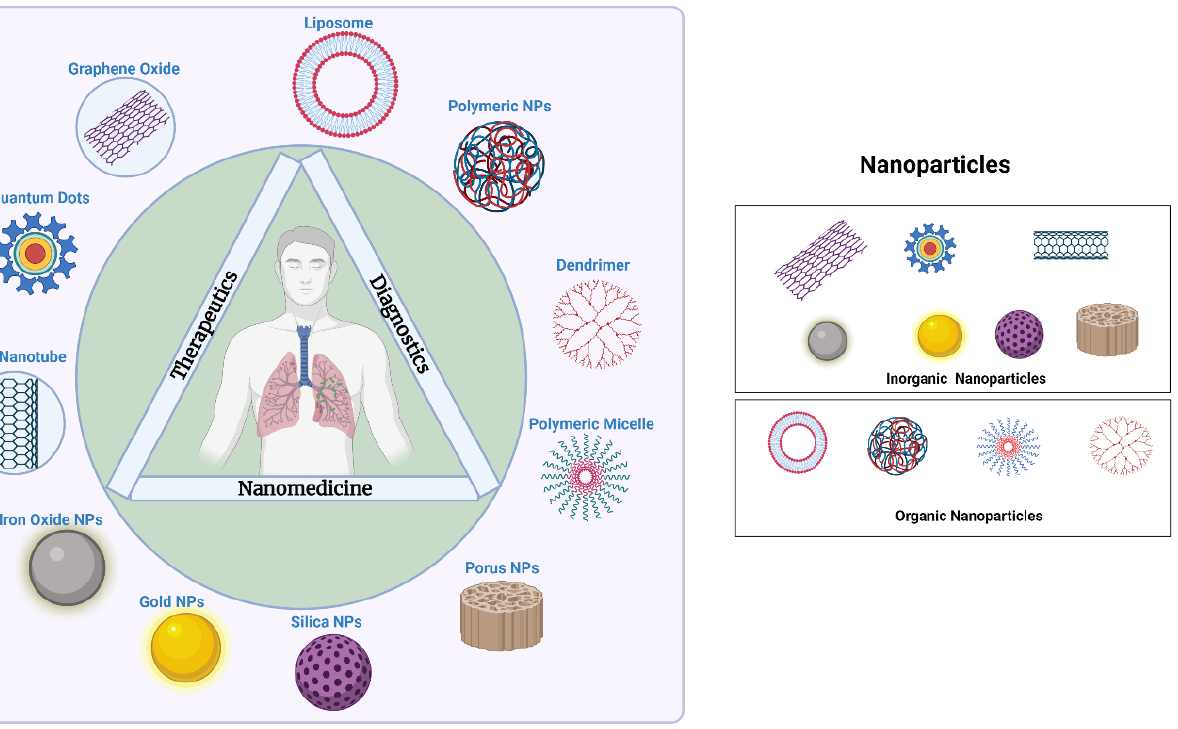
Figure 4. List of the different nanocarriers used in TB diagnosis and treatment (Created with Bio- Render.com).